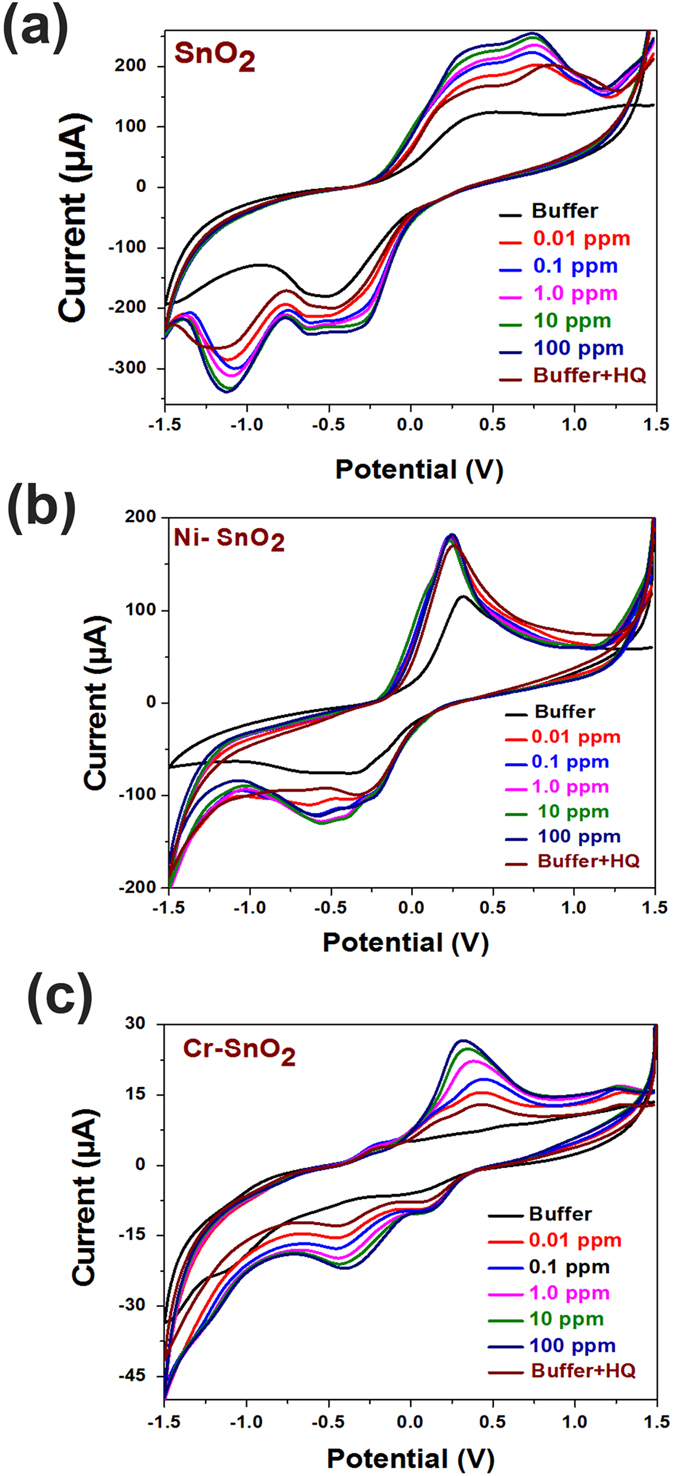
Interference studies with 1 ppm of HQ in various concentrations of OP for (a) SnO2 (b) Ni-SnO2 (c) Cr-SnO2.